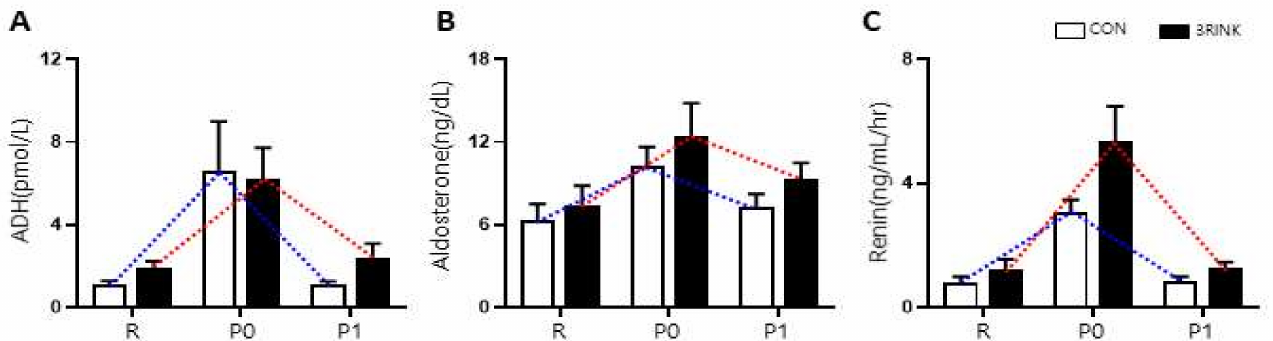
Figure 2. Changes in water regulating hormones according to the timing of fluid intake. Data for ( A ) ADH, ( B ) Aldosterone, ( C ) Renin represent the mean and SEM ( n = 10 per group). R = Rest, P0 = Right after exercise, P1 = 1 h after